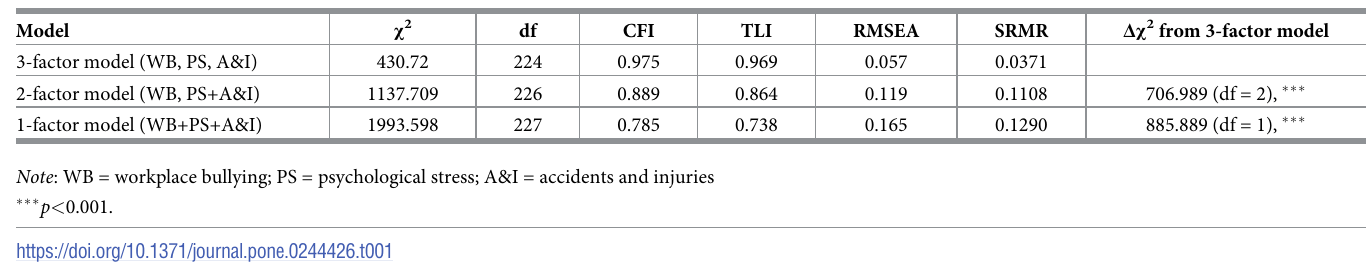
Table 1. Results for Chi-square difference test in Study